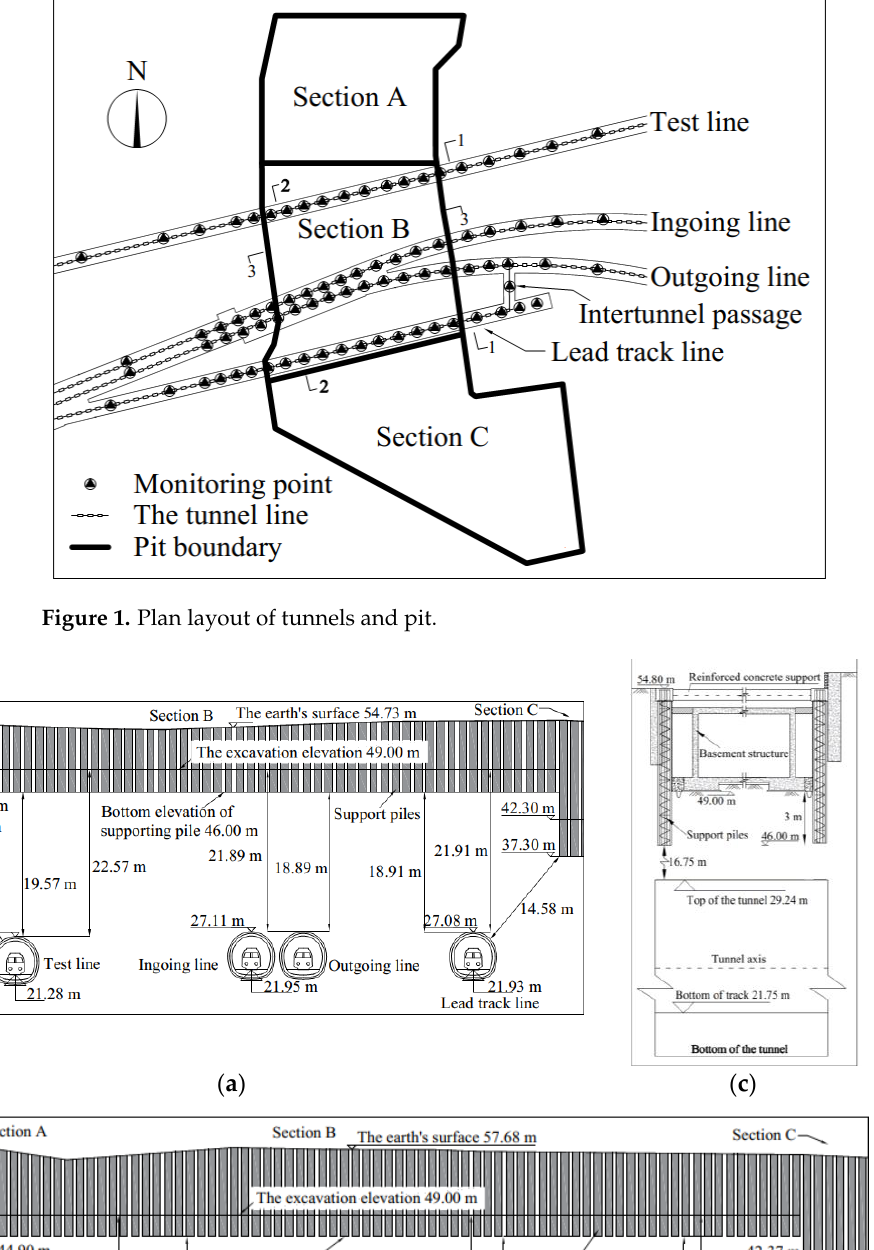
Figure 2. Profile of tunnels and deep excavations: ( a ) profile 1–1, ( b ) profile 2–2, ( c ) profile 3–3.